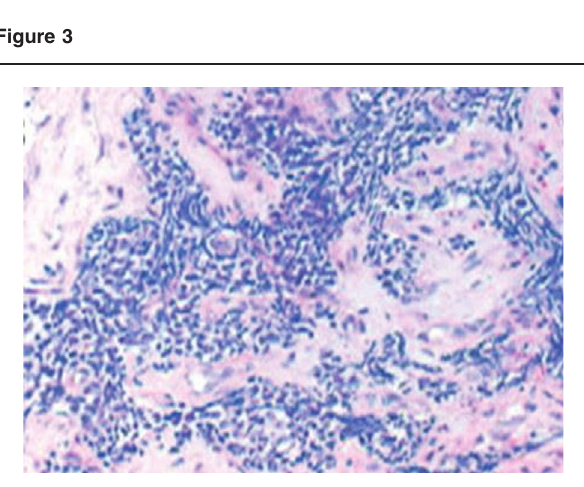
Histopathologic examination of the lung biopsy showing epitheliod and spindle neoplasm with a nested architecture.